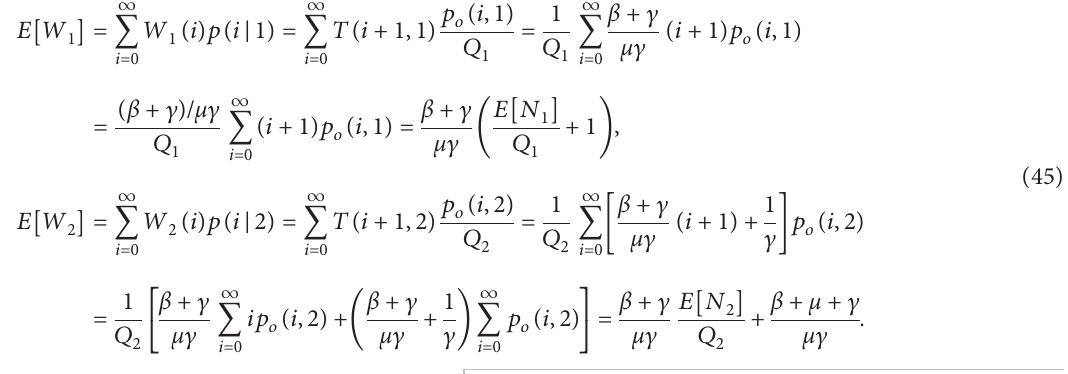
( λ ∗ , λ ∗ , λ ∗ ) and the system throughputd T o 0 1 2